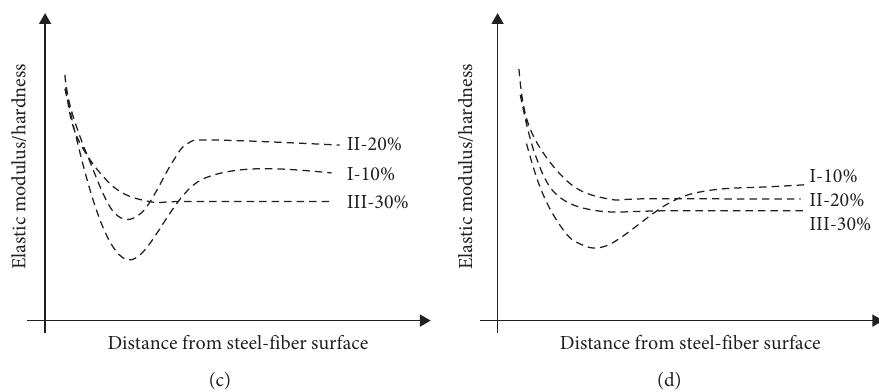
Figure 10: Profile characteristics of elastic modulus and indentation hardness in the ITZ. (a) Profile characteristics from the literature [20]. (b) Profile characteristics with different water-binder ratios and a silica fume content of 0%. (c) Profile characteristics with water-binder ratio of 0.24 (d) Profile characteristics with water-binder ratio of